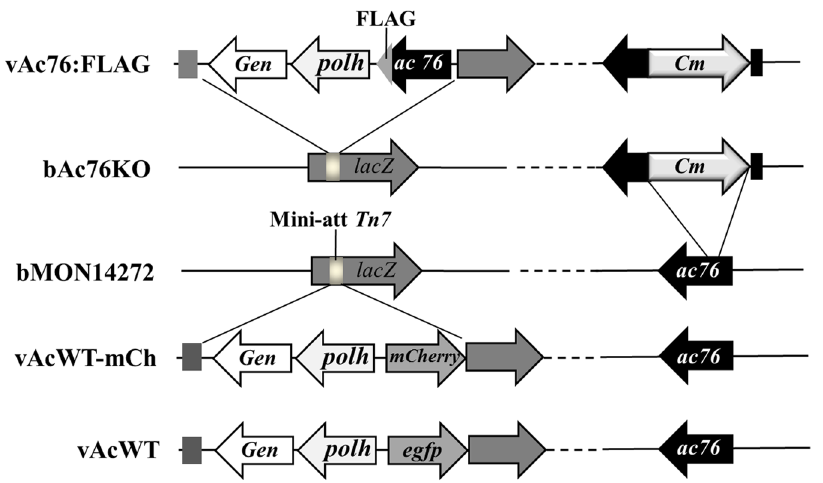
Figure 2. Schematic diagram of the AcMNPV bacmid constructs used in this study. The genes are indicated in a linear representation of the AcMNPV genome. Arrows denote the protein-coding regions and transcription orientations of the